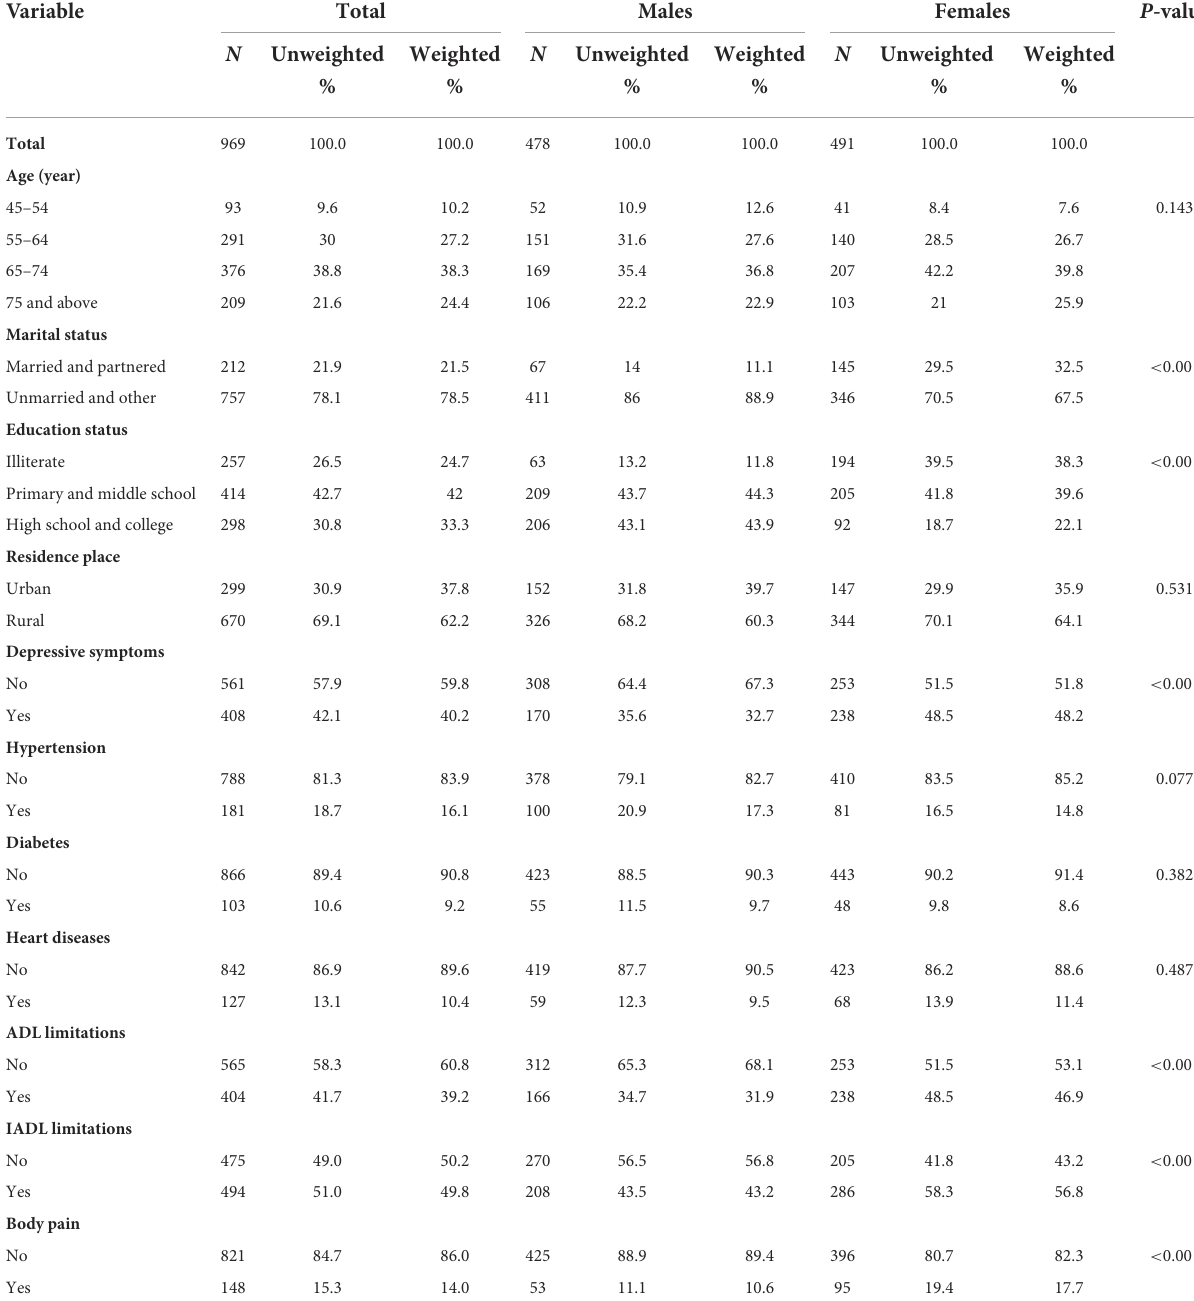
TABLE 2 Co-occurring chronic conditions among individuals with stroke in China, by gender group ( n = 969). Variable Total